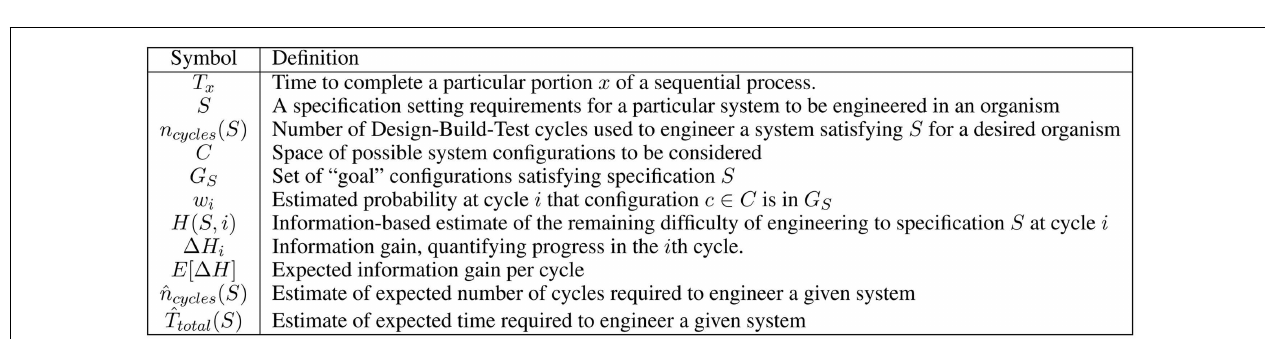
FIGURE 1 | When analyzing synthetic biology against a classic design-build-test cycle (A) , analysis of a single cycle hides the cost of design, since the relative effort expended in a single cycle is typically quite low: (B) illustrates this with typical examples of time expended in a single cycle: a few minutes or hours of design, followed by construction of a design via BioBrick assembly (Knight, 2003) from existing sequence fragments or via an